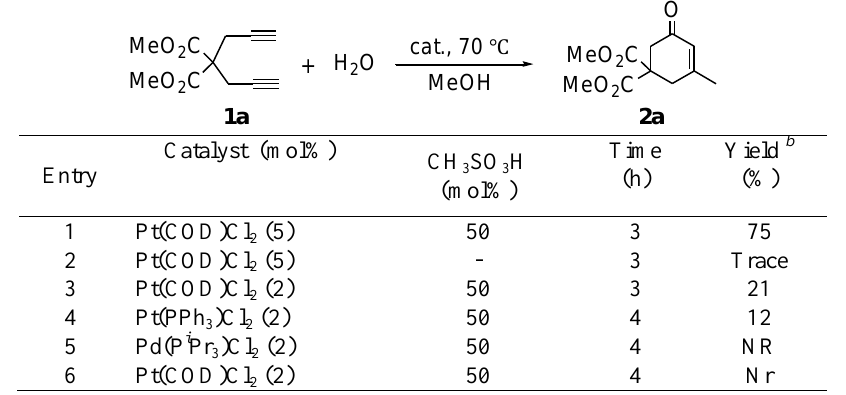
Table 1. Pt(II)-Catalyzed synthesis of cyclohexenone from 1,6-diyne a